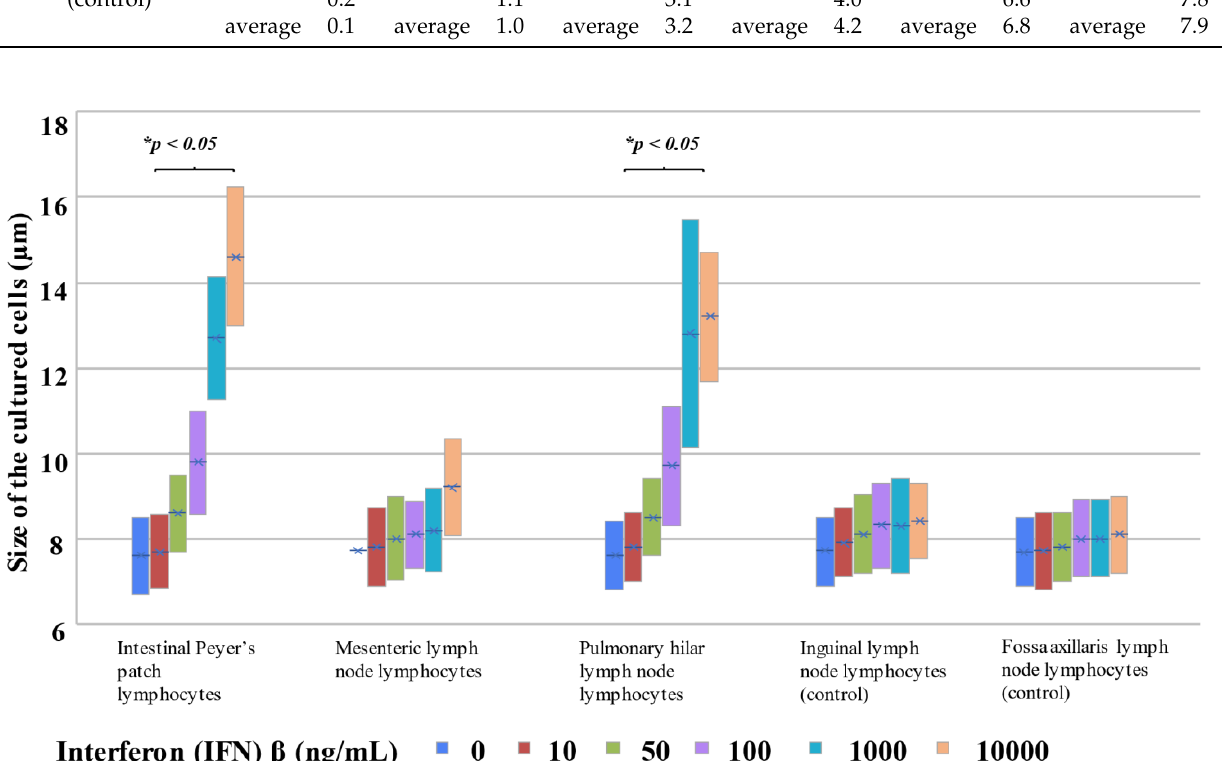
Figure 5. Cultured intestinal Peyer’s patch lymphocytes ( a ) before and ( b ) after the addition of 1000 ng/mL IFNβ.